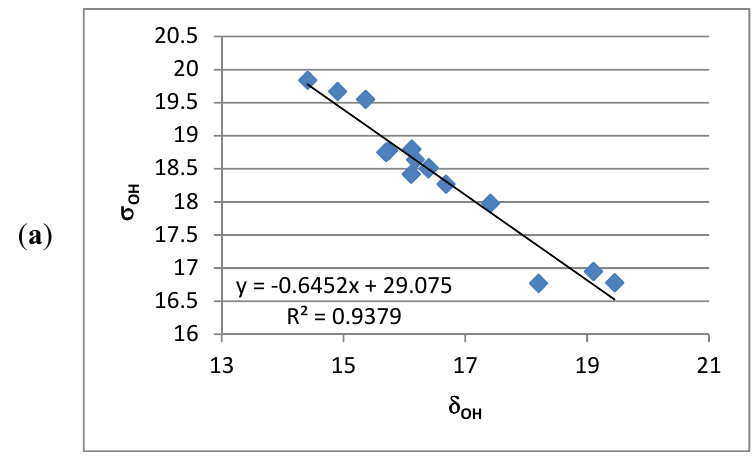
Figure 6. ( a ) Plot of OH nuclear shieldings vs. OH chemical shifts. ( b ) Plot of 1 H nuclear shieldings vs. 1 H chemical shifts for 9-dodecanoyl-HBQ.